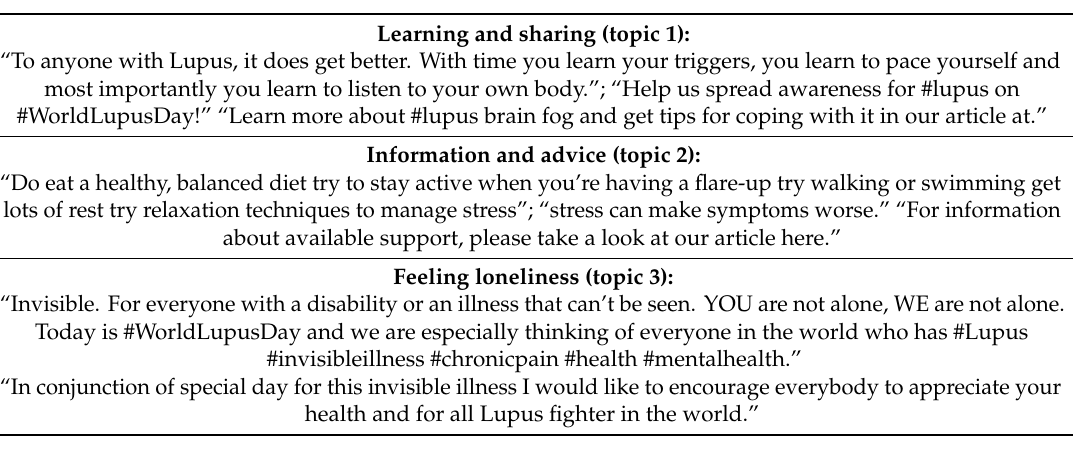
Table 2. Most representative tweet texts and topic label selection.